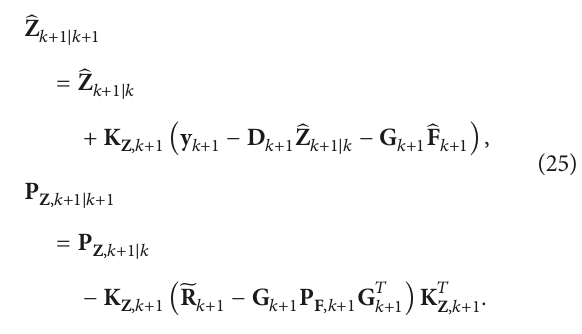
Using (16) and (21), the expression of P ZF ,𝑘+1|𝑘+1 and